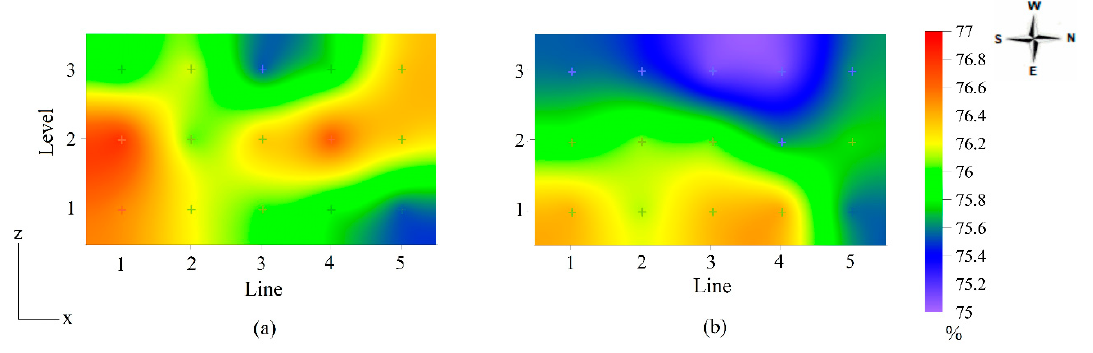
Figure 5. Spatial distribution, in cross-section, of the average egg shape index values obtained in the aviaries in winter ( a ) and summer ( b ).